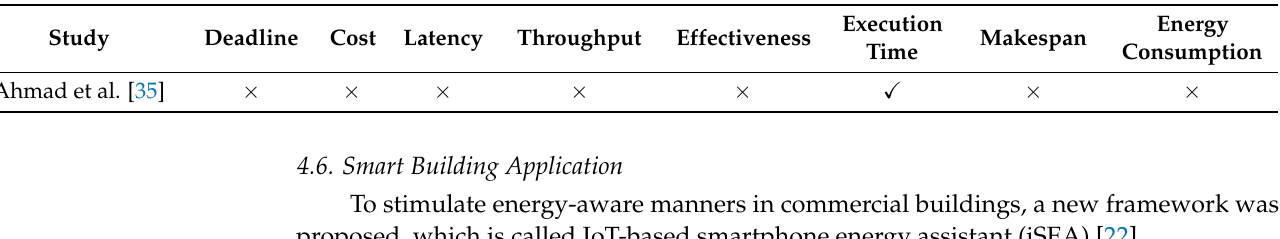
Table 11. Analysis of articles in terms of evaluation parameters in smart farming